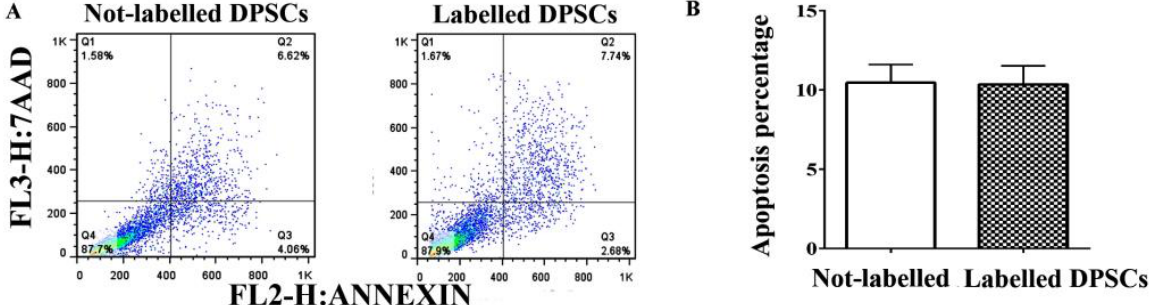
Figure 8. The flow cytometry analysis of annexin V+/7-AAD+ on DPSCs labeled with 180 µg/mL of iron oxide transfected with 1 µL/mL of lipofectamine. ( A ) Dead cells were scored as necrotic annexin V: negative/7-AAD: positive, upper left quadrants, Q1, or late apoptotic annexin V-positive/7-AAD- positive, upper right quadrants, Q2, early apoptotic annexin V-positive/7-AAD-negative, lower right quadrants, Q3, and following a gating on the normal cells that were considered viable were PE Annexin V and 7-AAD negative lower left quadrants, Q4. ( B ) The percentage of early and late apoptosis was indicated in a bar chart. Data presented were indicative of three independent experiments ( p = 0.95).